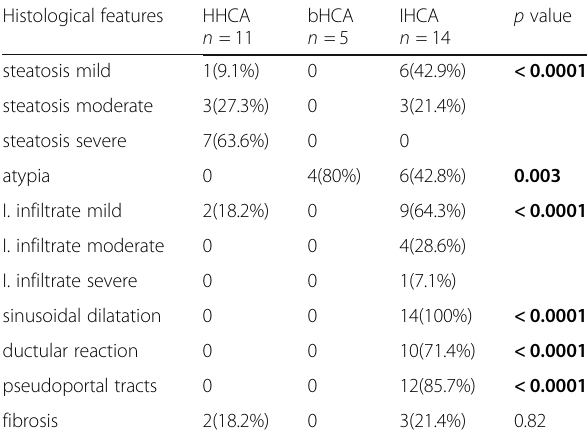
Table 1 Histological features of the hepatocellular adenomas by histological classification Histological